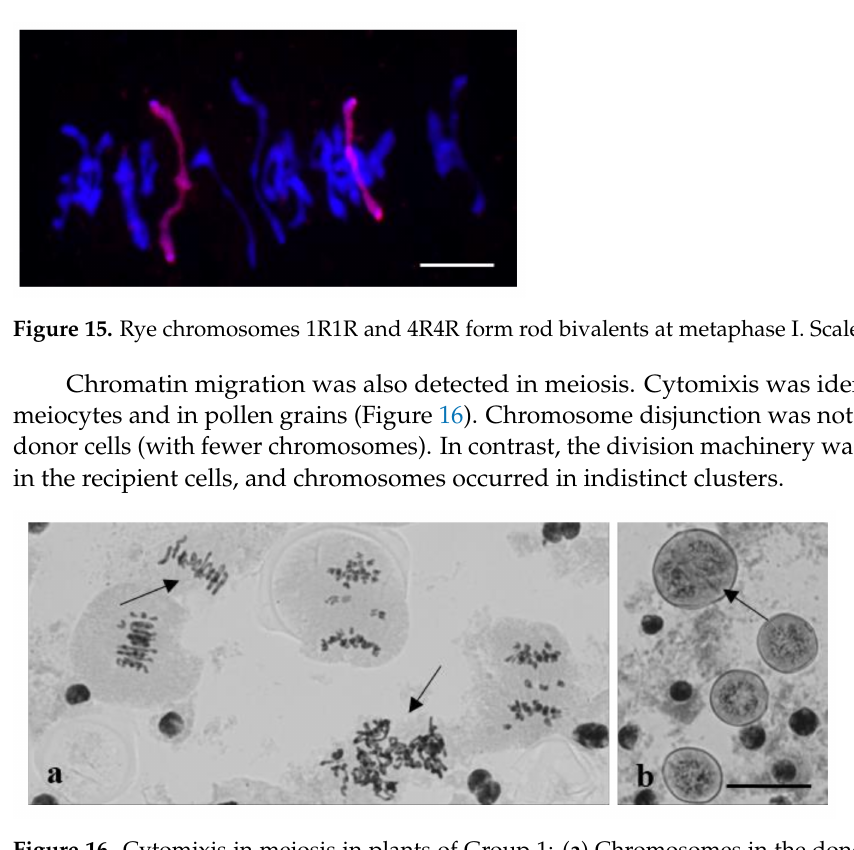
Figure 16. Cytomixis in meiosis in plants of Group 1: ( a ) Chromosomes in the donor cell behave normally, whereas abnormal chromosome behavior is observed in the recipient cell (shown with an arrow); ( b ) pollen grains of different sizes. Staining acetocarmine. Scale bar = 10 µ m. Univalents were found in 77.07 ± 2.01% of the meiocytes in metaphase I in Group 3 plants. They were formed from both wheat and rye chromosomes (Figure 17a,b). Mi- cronuclei were detected in 68.9 ± 3.86% of the microsporocytes in telophase II (Figure 17d). Some meiocytes showed no chromosome pairing at all (Figure 17c).